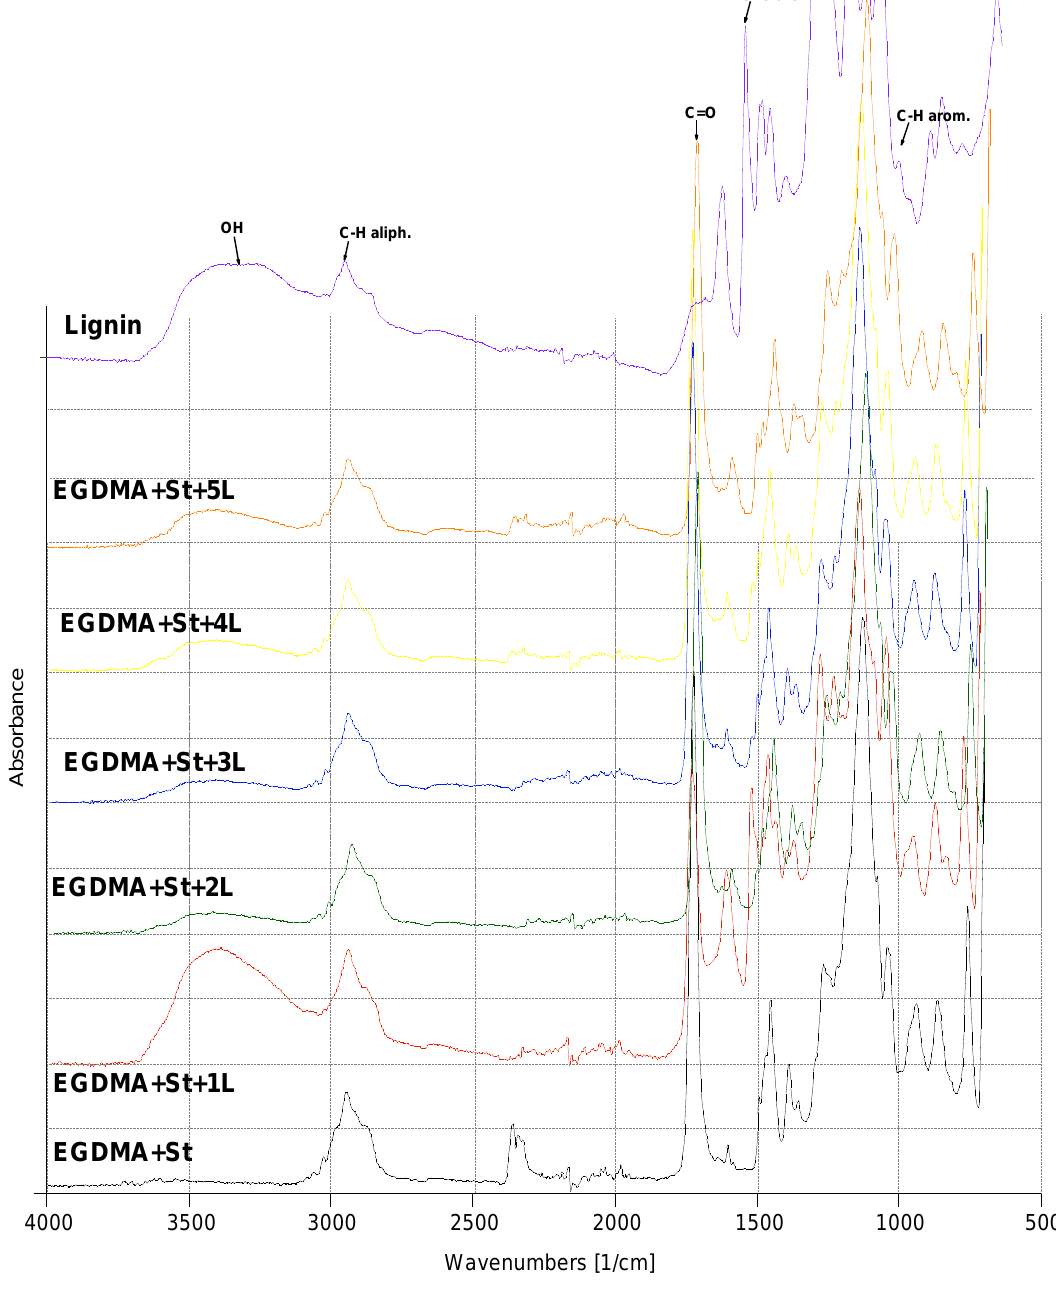
Figure 4. Attenuated Total Reflectance/Fourier Transform Infrared spectra of lignin and copolymers.